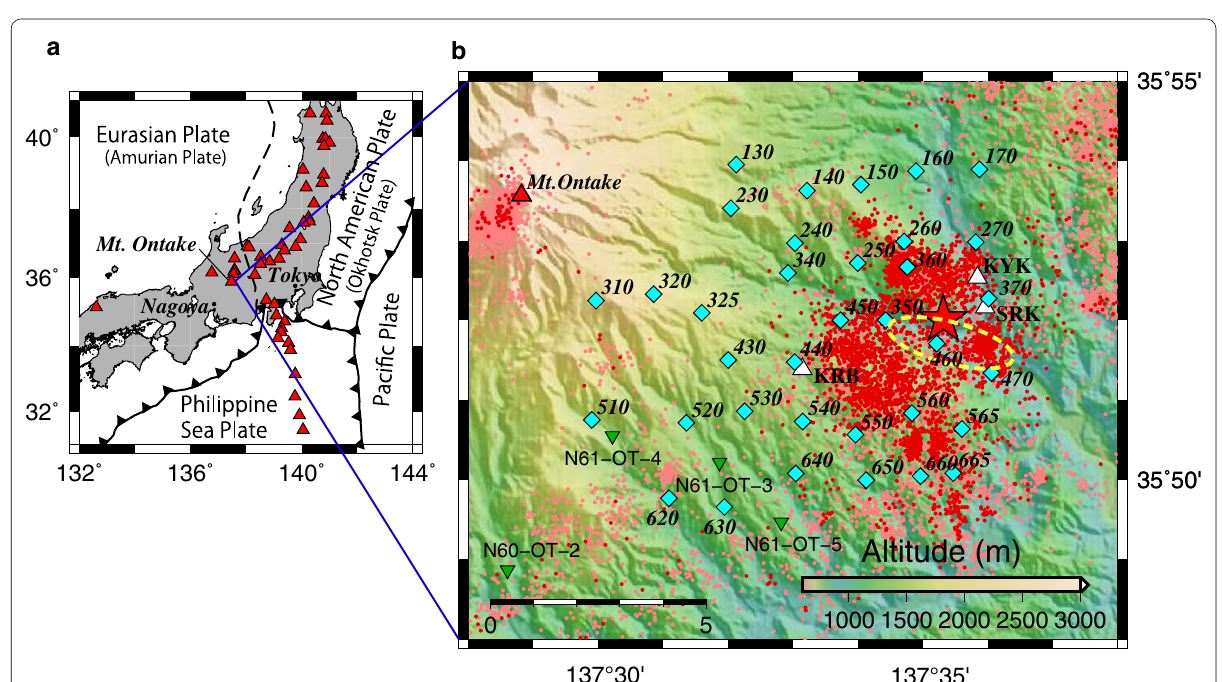
Fig. 1 a Index map. Red triangles denote active volcanos. Thick black lines show plate boundaries. b Topographic map of the study area with MT sites and seismicity. Cyan diamonds denote MT sites. Dark red and light red circles denote epicenters before and after June 24, 2017, respectively, manually estimated by Nagoya University (2017). The yellow dashed line represents the area of crustal deformation (Kimata et al. 2004). White triangles denote sampling locations of spring water indicating lower crust or mantle origin (Nishio et al.